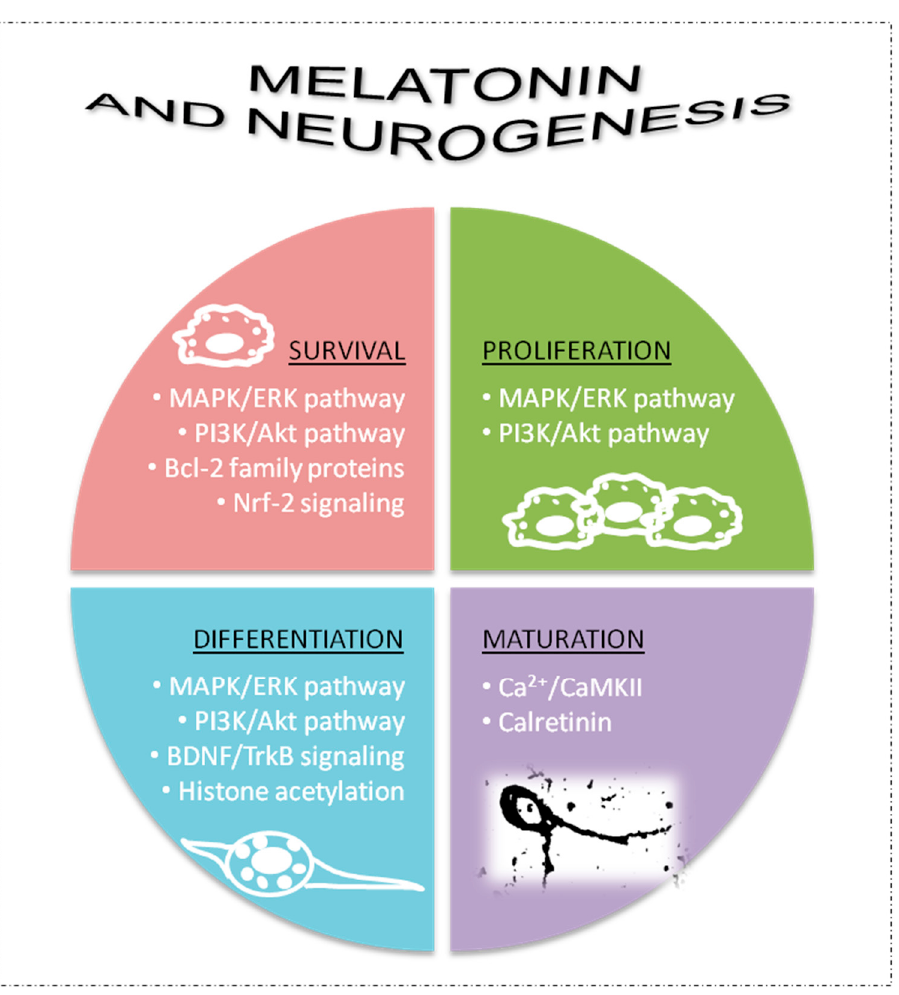
Figure 2. Some of mechanisms involved in the neurogenic potential of melatonin. AkT, protein kinase B; Bcl-2, B-cell lymphoma; BDNF, brain-derived neurotrophic factor; Ca 2+ /CaMKII, calcium/calmodulin-dependent kinase II; ERK, extracellular signal-regulated kinases; GDNF, glial cell line-derived neurotrophic factor; Nrf-2, nuclear factor erythroid 2-related factor 2; MAPK, mitogen ‐ activated protein kinases; PI3K, phosphoinositide 3 ‐ kinase; TrkB, tropomycin ‐ receptor kinase B.